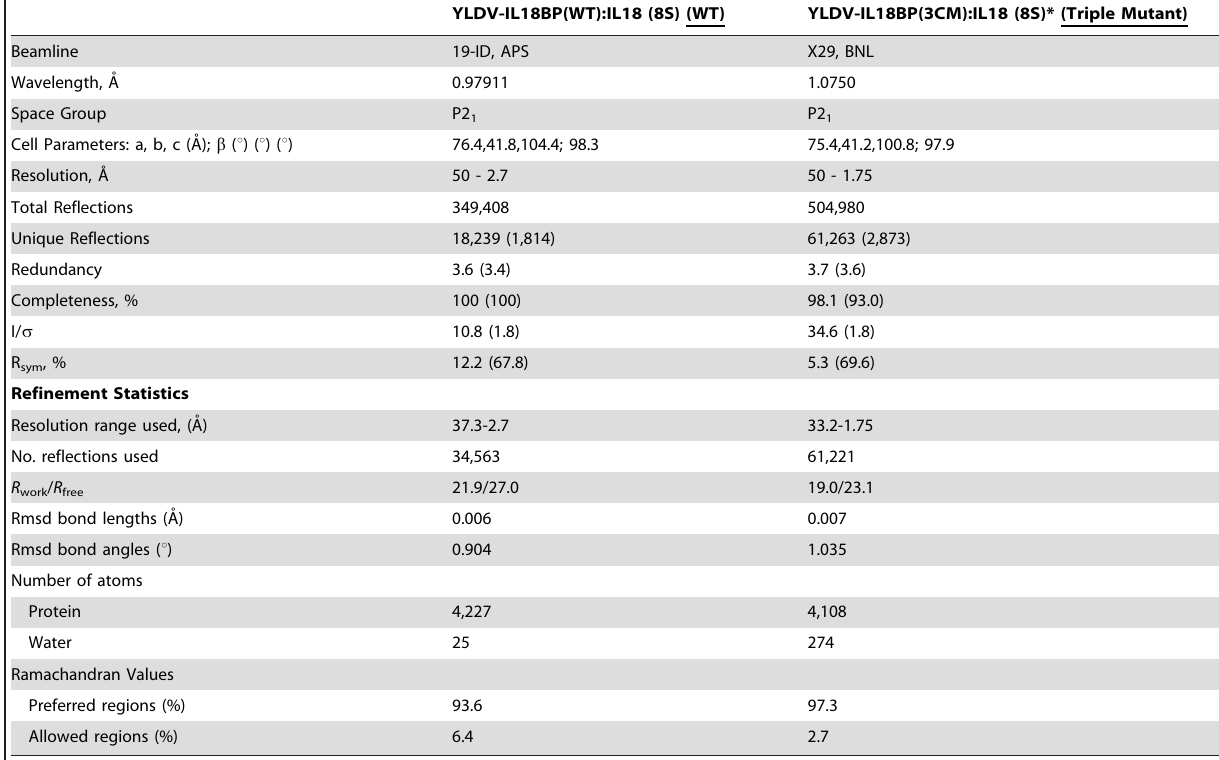
Table 1. X-Ray crystallographic data and refinement